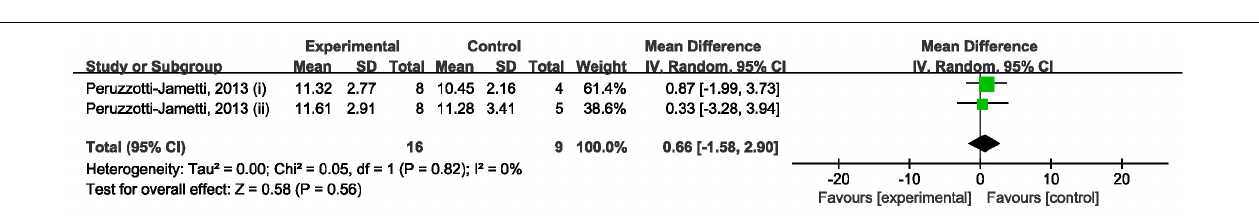
FIGURE 4 | Forest plot analysis of the efficacy of anodal tDCS on mNSS compared to